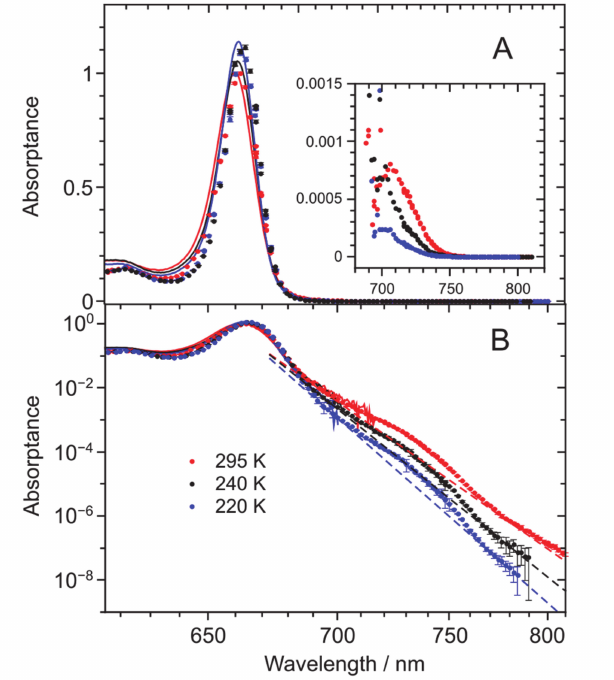
Figure 2. Integral intensity-normalized absorptance (solid lines) and fluorescence excitation (discrete symbols marked with the experimental uncertainty) spectra recorded at di ff erent temperatures indicated and presented in linear ( A ) and half-logarithmic ( B ) scale. Shown in the inset of A are the amplified “hunch” spectra, i.e., di ff erences between the actually measured excitation spectra and their approximate presentations as exponentially decaying tails depicted by dashed lines in B . Concentration of the samples about the same as in Figure